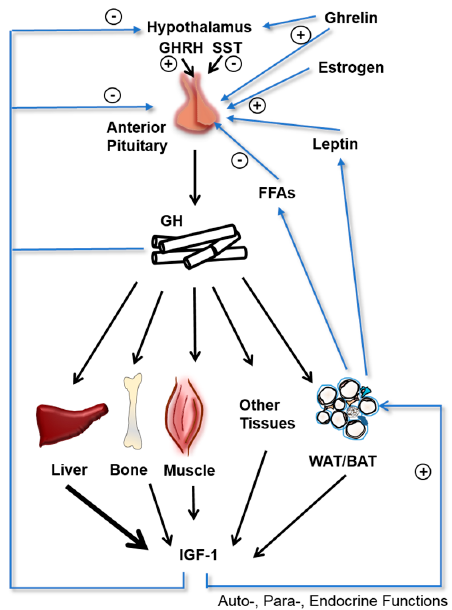
Figure 1. Regulation of growth hormone (GH) and Insulin-like growth factor (IGF)-1 Secretion. GH secretion by the anterior pituitary into the circulation is regulated in a complex manner. The hypothalamus secretes GH releasing hormone (GHRH) and Somatostatin (SST) which increase and decrease GH secretion, respectively. Endocrine GH travels through the bloodstream and stimulates IGF-1 secretion in multiple target tissues, with the liver as the primary source of circulating IGF-1. GH secretion is regulated by multiple negative feedback loops, with high GH levels and IGF-1 levels inhibiting GH secretion at the hypothalamic and pituitary level. GH secretion is also negatively regulated by serum free fatty acids (FFAs) and positively regulated by ghrelin, estrogen, and leptin. Black arrows indicate actions of GH on target tissues and resulting IGF-1 generation with the liver being the dominant source. Blue arrows indicate positive (+) and negative ( − ) regulatory mechanisms on GH secretion.